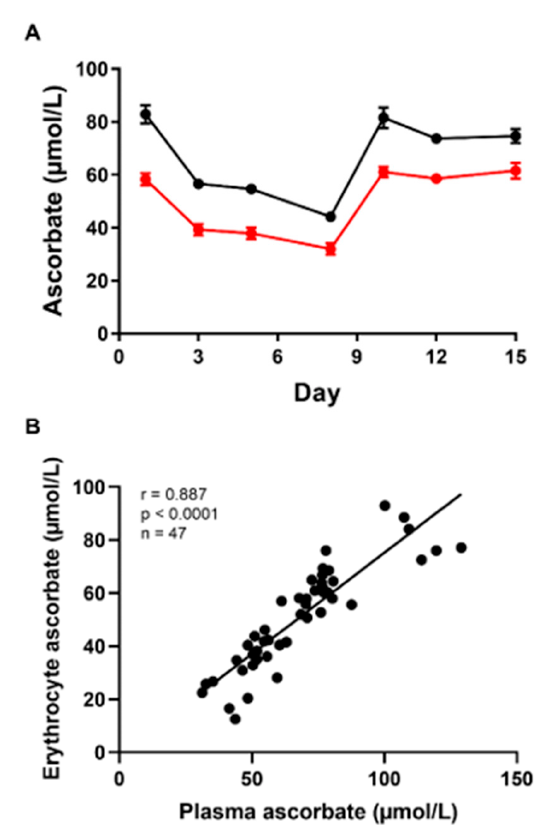
Figure 2. Changes in steady-state ascorbate concentrations during the two-week study. ( A ) Fasting plasma ( • ) and erythrocyte ( • ) ascorbate concentrations over time. Each symbol represents the mean ± SEM of 5to 7 individuals, as not all 7 individuals provided samples on each day of the study. ( B ) Linear correlation of the plasma and erythrocyte ascorbate concentrations (n = 47 points). For Figure A, paired t-tests showed that days 3, 5 and 8 were significantly di ff erent to the baseline for both plasma and erythrocytes. For Figure B, a Pearson linear correlation analysis was